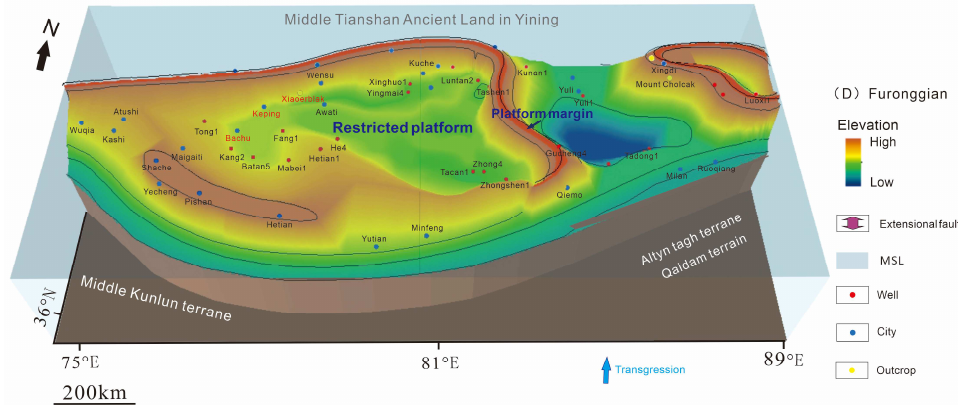
Figure 6. Sedimentary paleogeomorphic characteristics of Cambrian Furongian in the Tarim Basin.